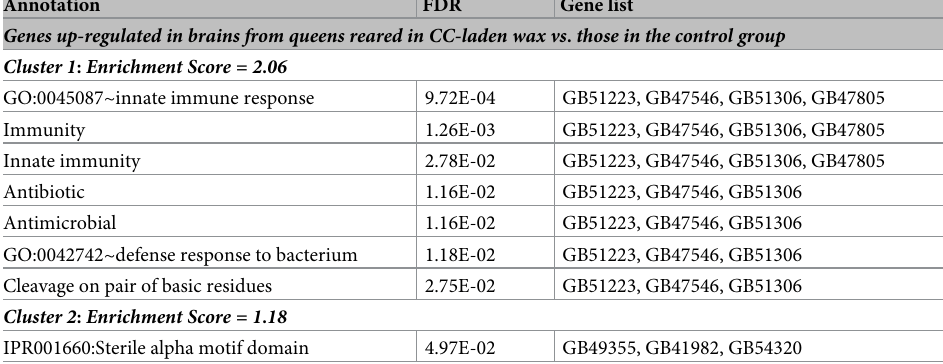
Table 5. Cluster analysis of differentially expressed genes in brain tissues from queens reared in wax containing a mix of chlorpyrifos and chlorothalonil ("CC") compared to those reared in untreated (control) wax, using the online tool D.A.V.I.D. (Huang et al.